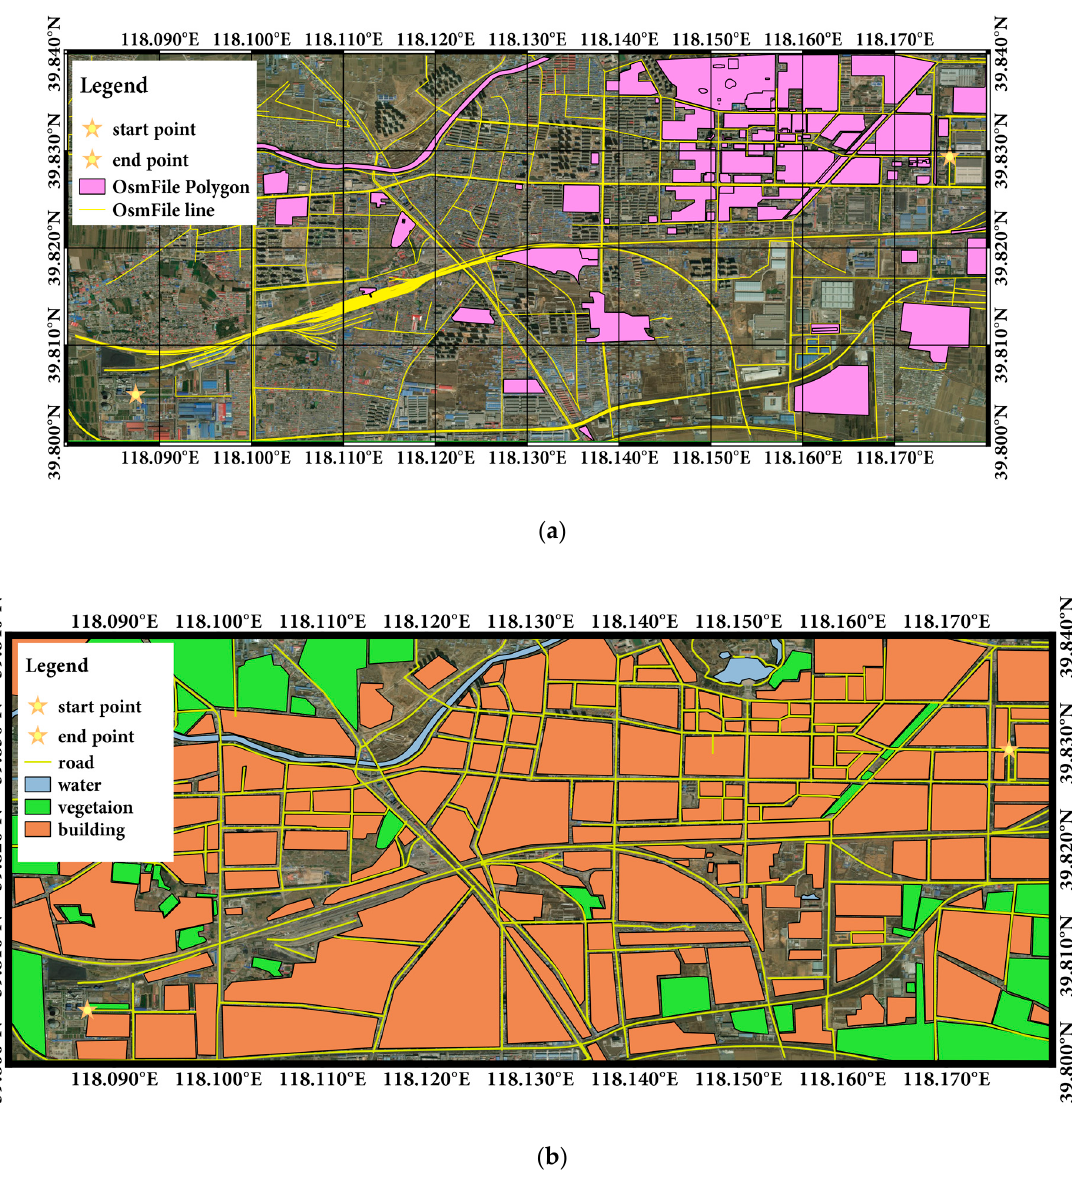
Figure 2. Classification data of the study area. ( a ) The downloaded data from OSM; ( b ) The reprocessed classification maps.